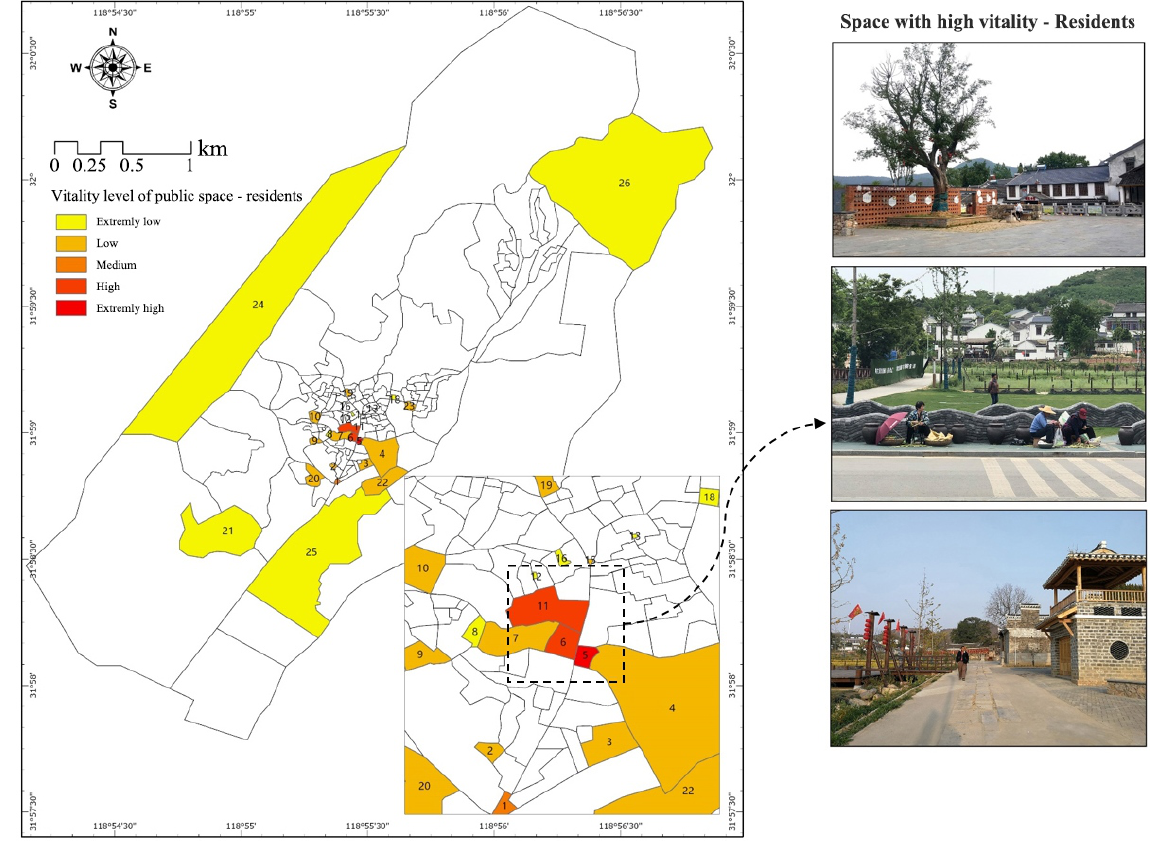
Figure 4. . Figure 4. Public Space